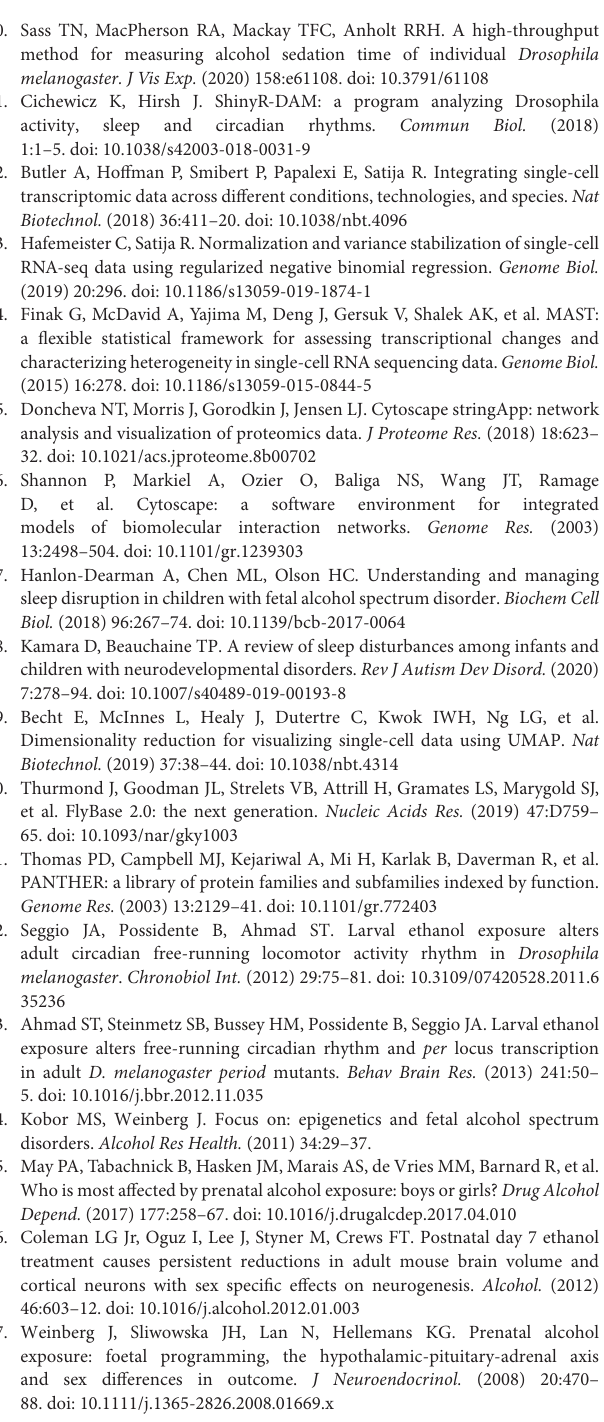
the comparisons between the two datasets for each cell type-category. The comparisons were done for each cell type-category separately for the male and female datasets. Supplementary Table 9 | Gene ontology analysis of differentially expressed genes identified both after developmental exposure to alcohol and acute intake of